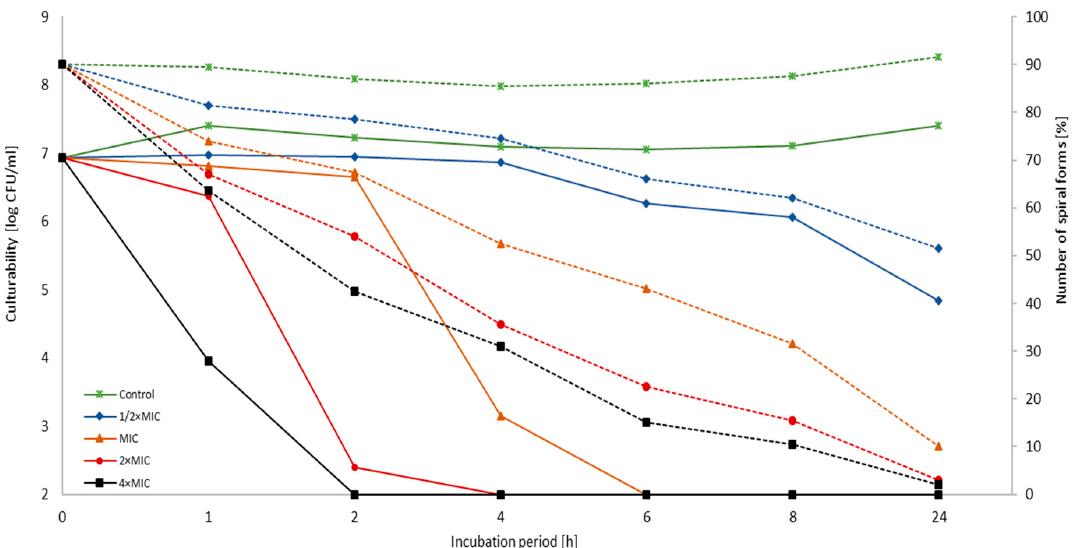
Figure 2. The effect of 3-Bromopyruvate (3-BP) on the culturability and morphology of H. pylori J99 during the incubation period. The number of spiral forms is marked with dotted lines, while the culturability is indicated by continuous lines.